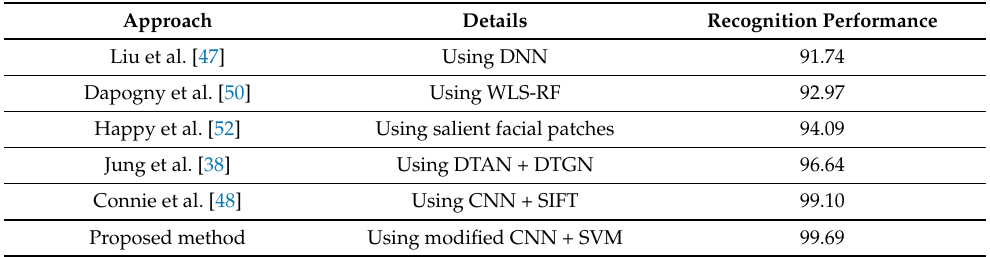
Table 10. Facial expression recognition performance in different approaches for CK+